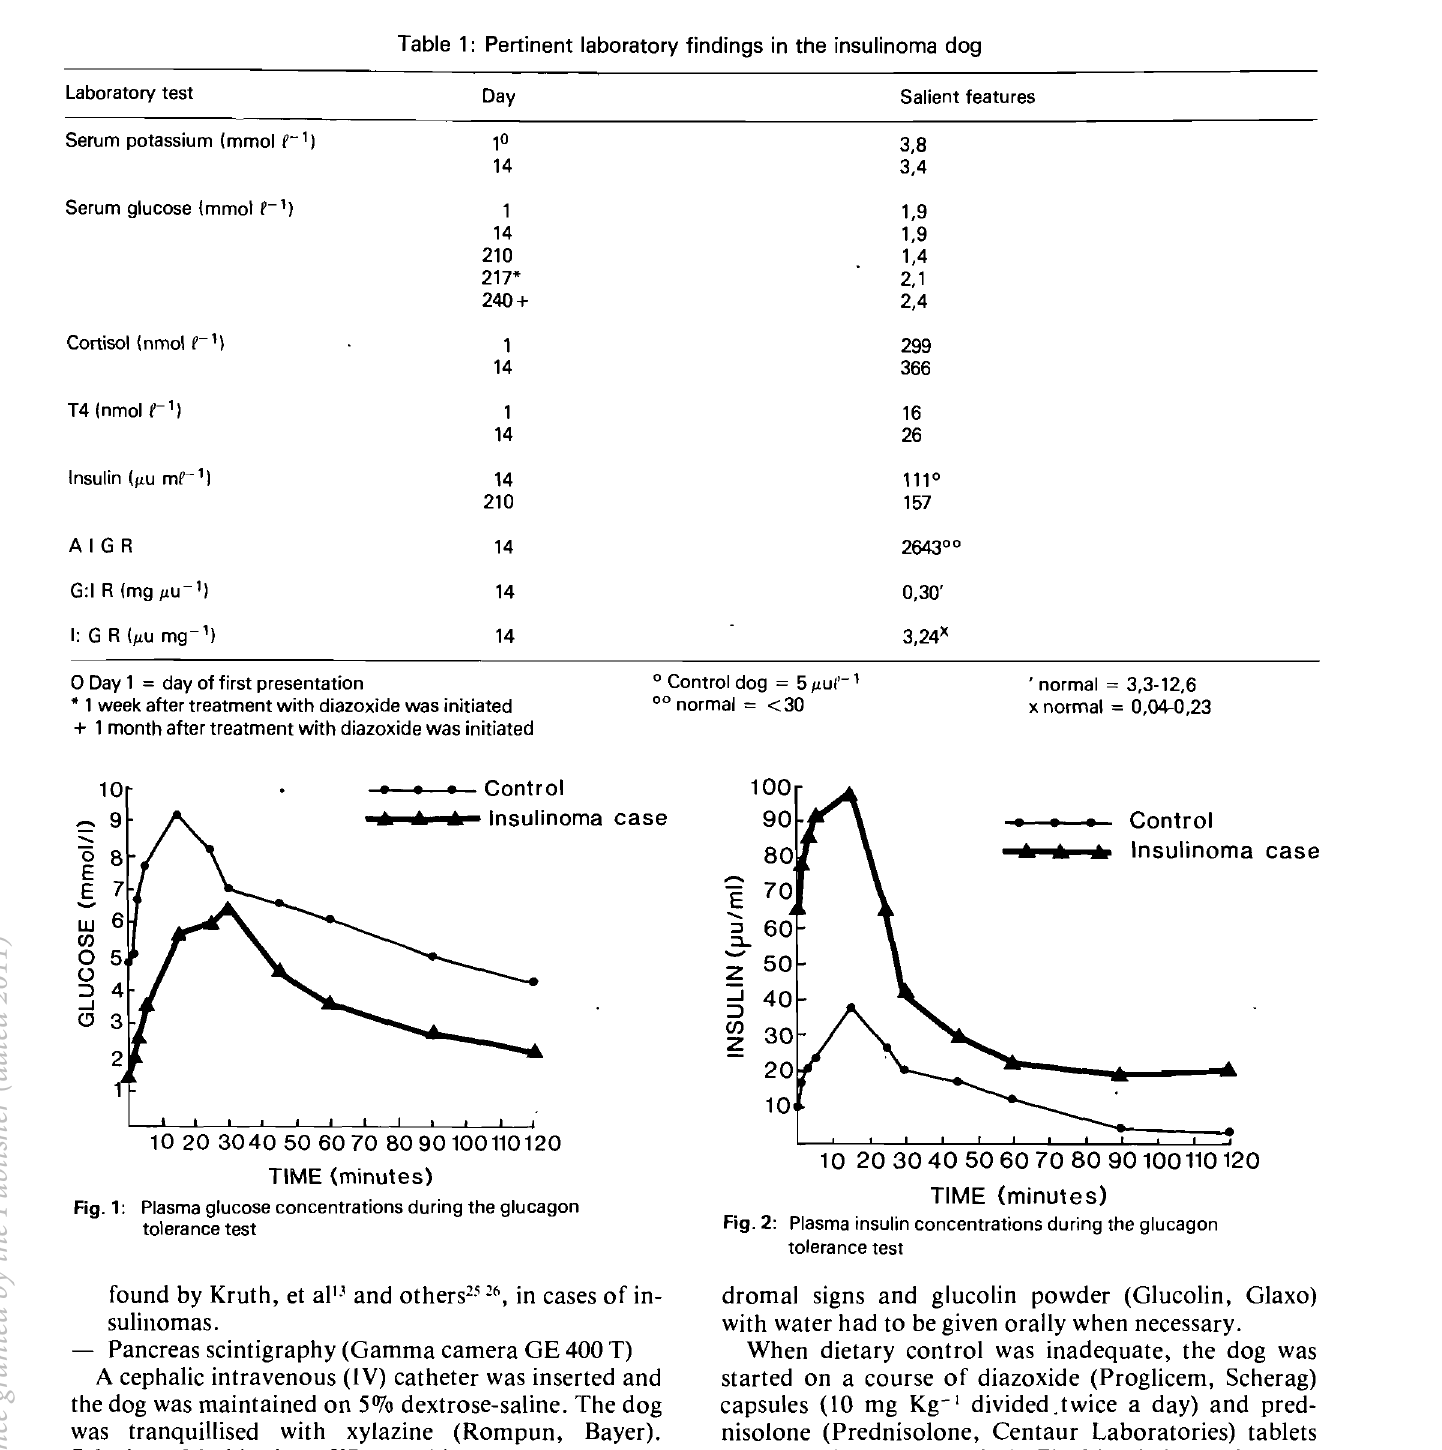
Table 1: Pertinent laboratory findings in the insulinoma dog